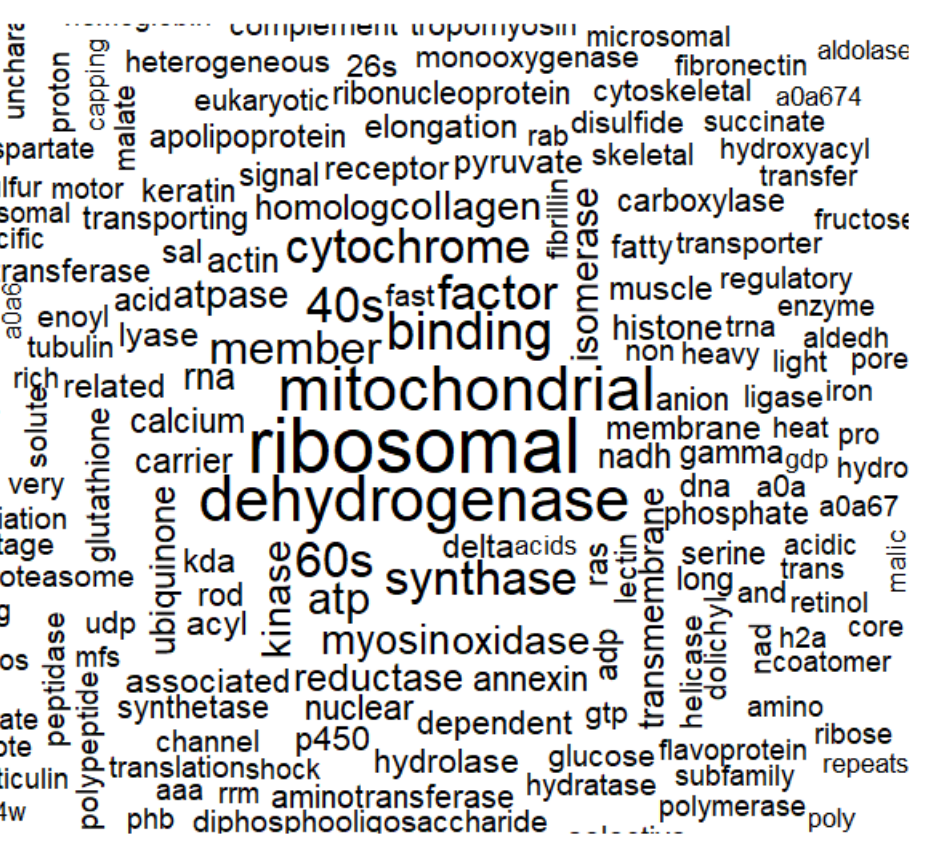
Figure 12. Words cloud by frequency of occurrence among identified proteins. Note: the closer to the center and the larger the font, the more often the word appears. The minimum frequency of occurrence of a word is 10